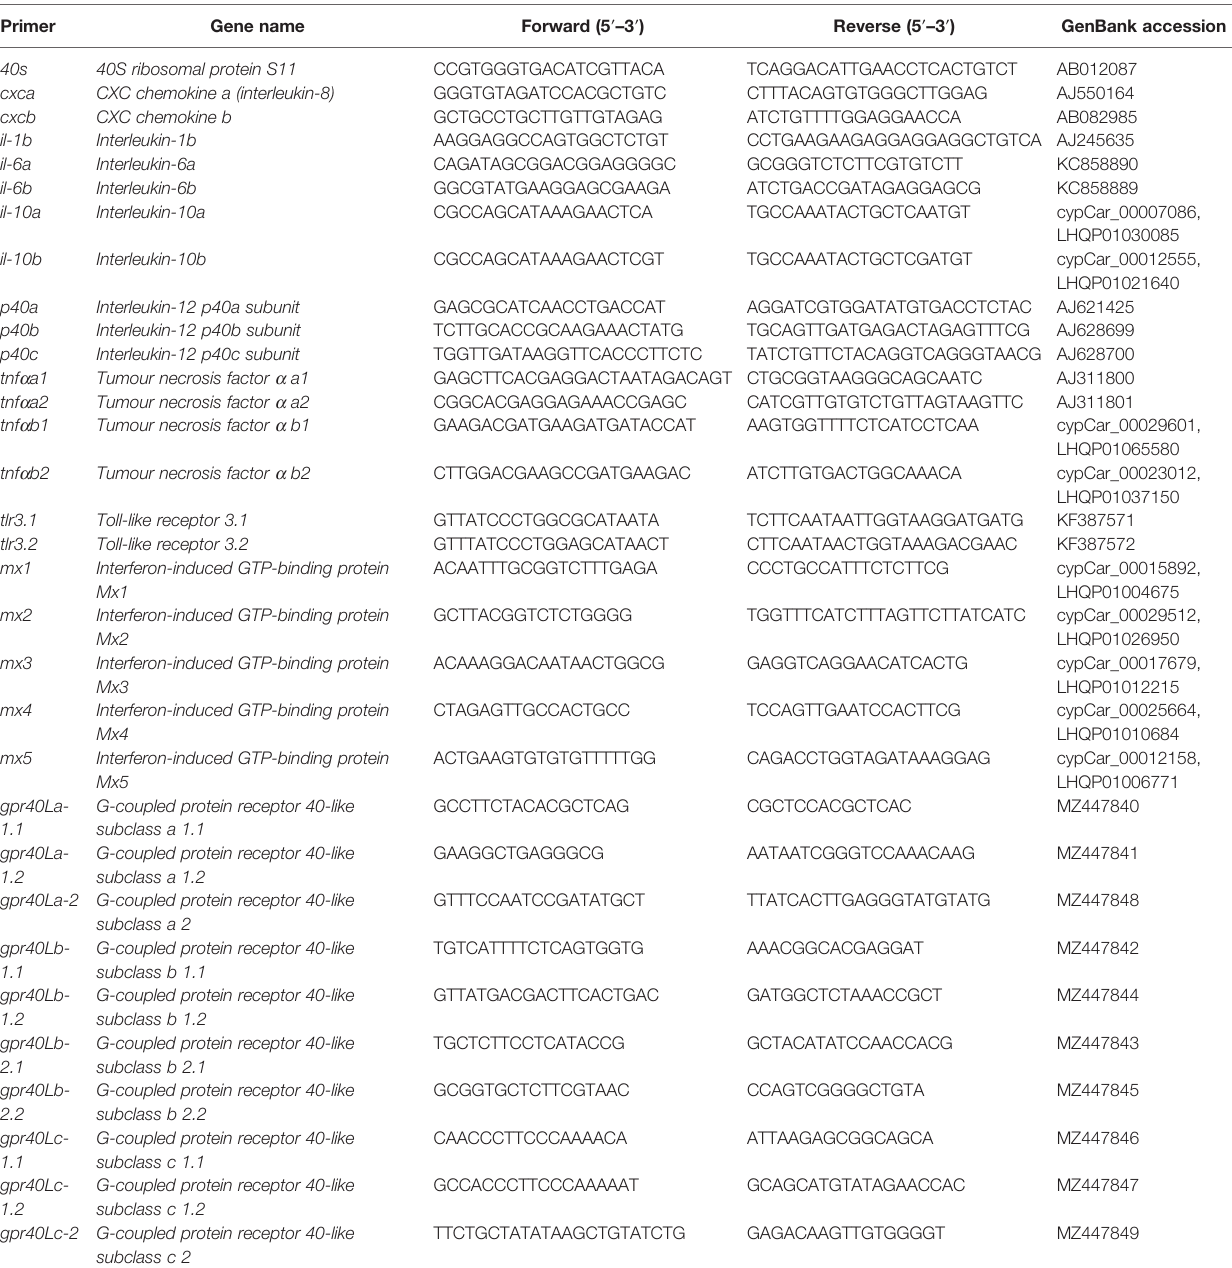
TABLE 1 | Overview of RT-qPCR primers used for in the current